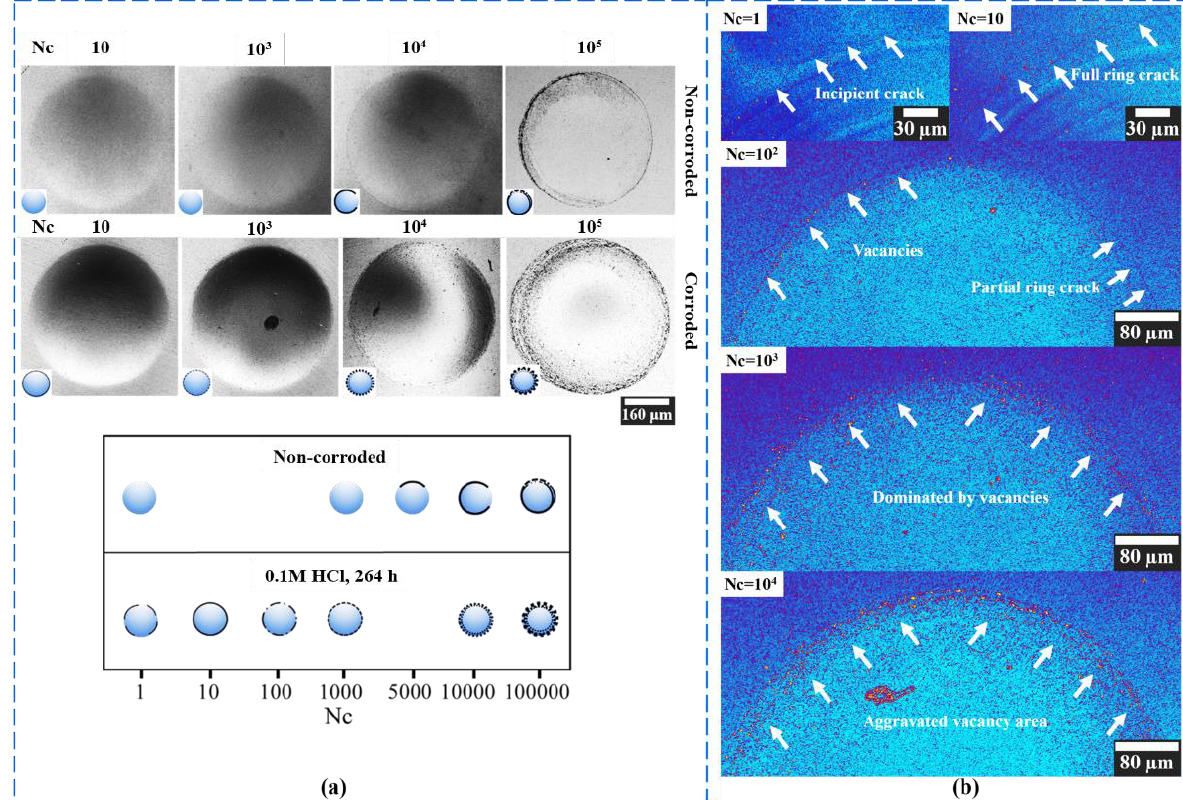
Figure 7. ( a ) Surface damage scenario and corresponding damage evolution diagrams and ( b ) LSCM micrographs of damage scenario at regions close to the contour of impressions resulting from contact fatigue tests performed (under a maximum applied load of 2000 N) on corroded specimens at a different number of cycles (adapted from Ref. [46]).